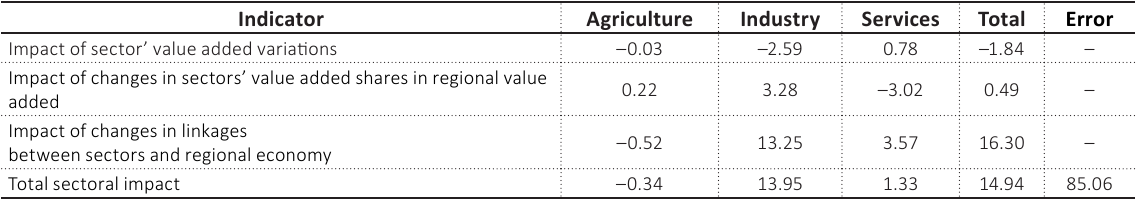
Source: Own calculations.